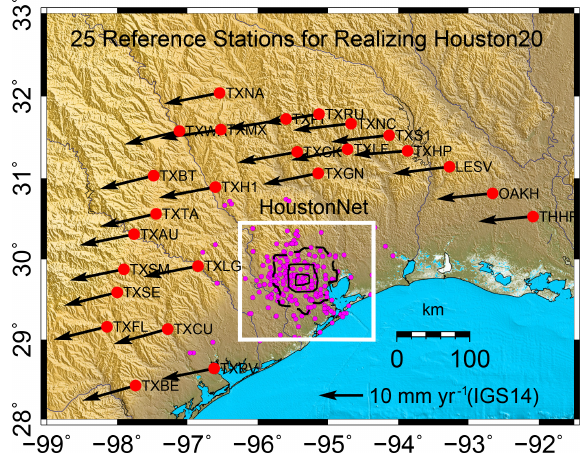
Figure 2. Locations and horizontal velocity vectors (referred to IGS14) of 25 reference stations utilized to realize